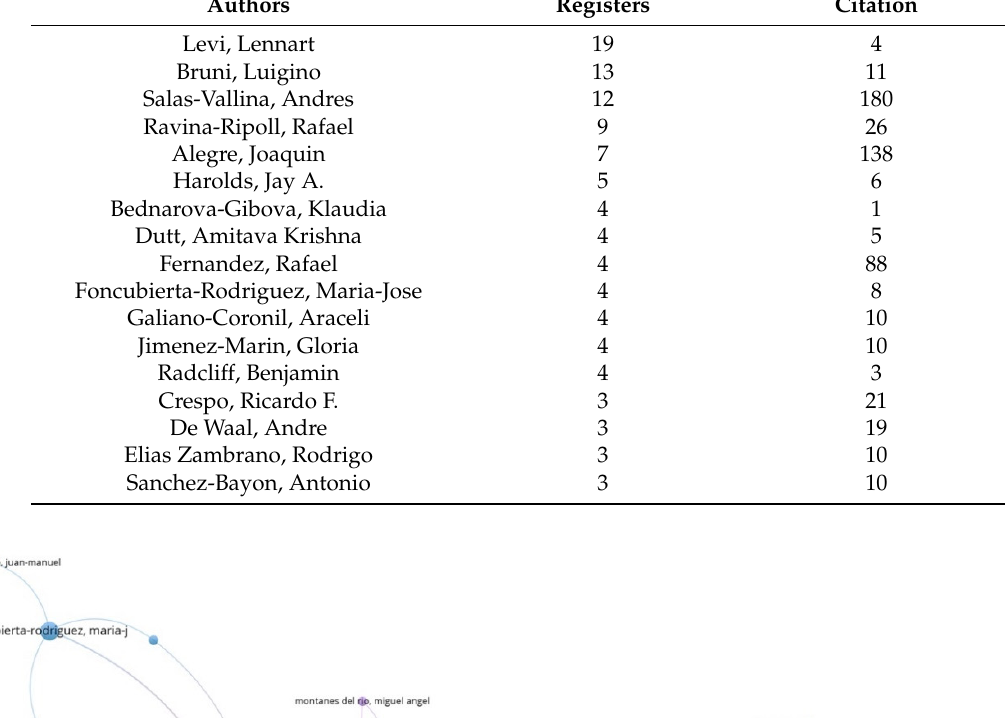
Table 3. Ranking of authors with the highest numbers of registers and citations.